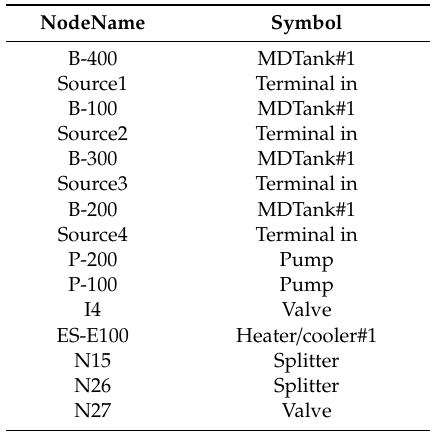
Table 2. Components (i.e., symbol in Balas ® ) of the steady state model